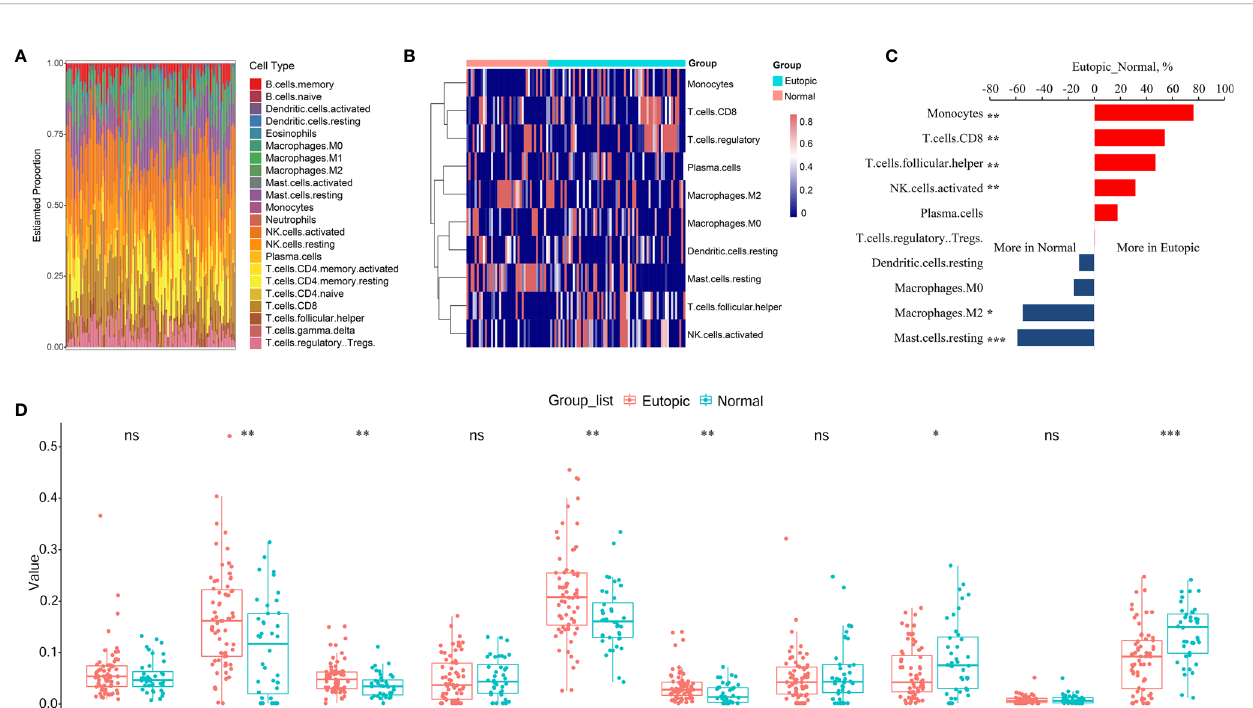
FIGURE 2 | The estimation of in fi ltrating immune cells in the endometria with or without endometriosis in the GEO cohort by CIBERSORT. (A) The stacked bar plot fi gure shows the inferred composition of 22 immune cell subsets in the endometria. (B) The heatmap shows the estimated proportions of 10 major immune cell subsets (plasma cells, CD8 T cells, follicular helper T cells, regulatory T cells, activated NK cells, monocytes, M0 macrophages, M2 macrophages, resting dendritic cells, and resting mast cells) in the endometria. (C) Comparisons of immune cells more in endometriosis or more in normal samples. (D) Boxplots comparing the proportions of 10 major immune cell subsets between normal and endometriosis samples. Data were assessed by the Wilcoxon rank-sum test. *P < 0.05, **P < 0.01, and ***P < 0.001. ns, no signi fi